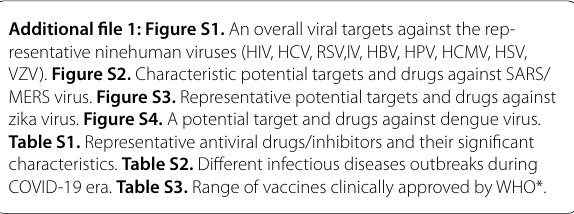
zika virus. Figure S4. A potential target and drugs against dengue virus. Table S1. Representative antiviral drugs/inhibitors and their significant characteristics. Table S2. Different infectious diseases outbreaks during COVID-19 era. Table S3. Range of vaccines clinically approved by